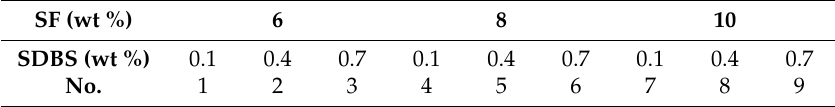
Table 1. Composition and concentration of the spinning